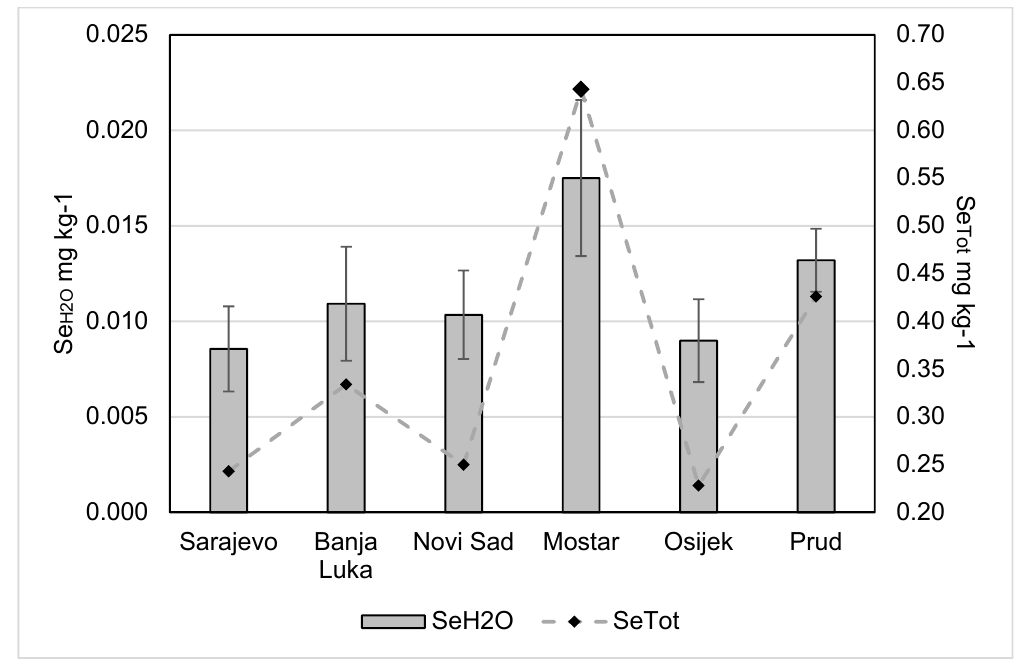
Figure 2. Se H2O concentrations are shown on the left and Se Tot on the right side through studied locations. Location effects were significant in both analyzed parameters at p < 0.001 in one-way analysis of variance.